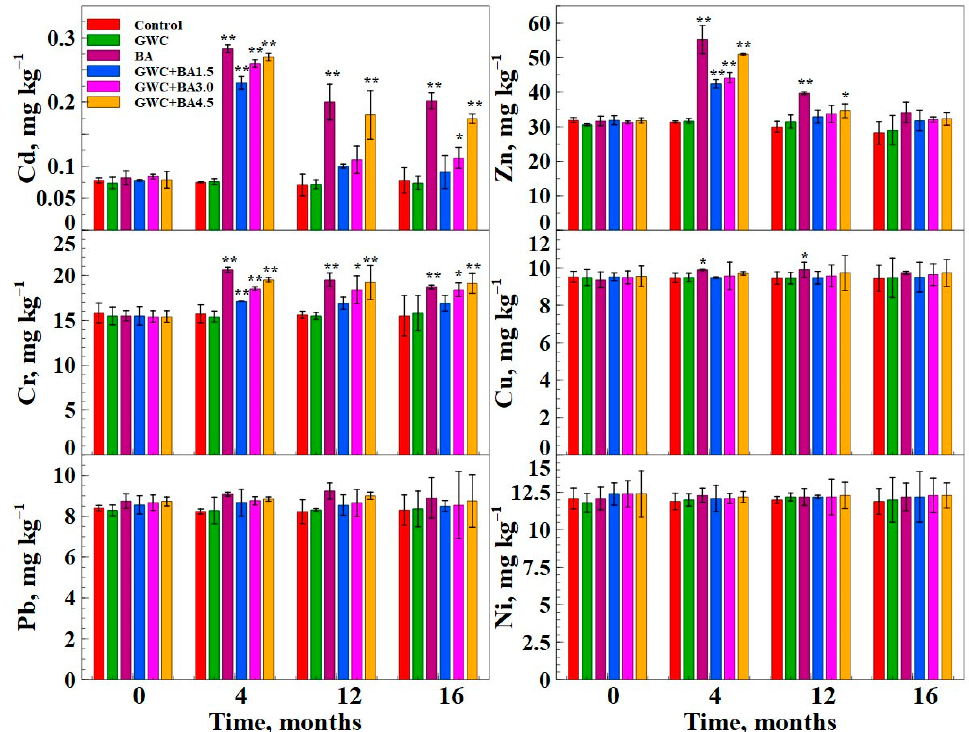
Figure 3. Heavy metals measured in the soil within 16 months. * = significance at p ≤ 0.05 and ** = significance at p < 0.01. BA—biofuel ash; GWC—green waste compost; GWC+BA1.5—green waste compost (20 t ha − 1 ) + biofuel ash (1.5 t ha − 1 ); GWC+BA3.0—green waste compost (20 t ha − 1 ) + biofuel ash (3.0 t ha − 1 ); GWC+BA4.5—green waste compost (20 t ha − 1 ) + biofuel ash (4.5 t ha − 1 ).